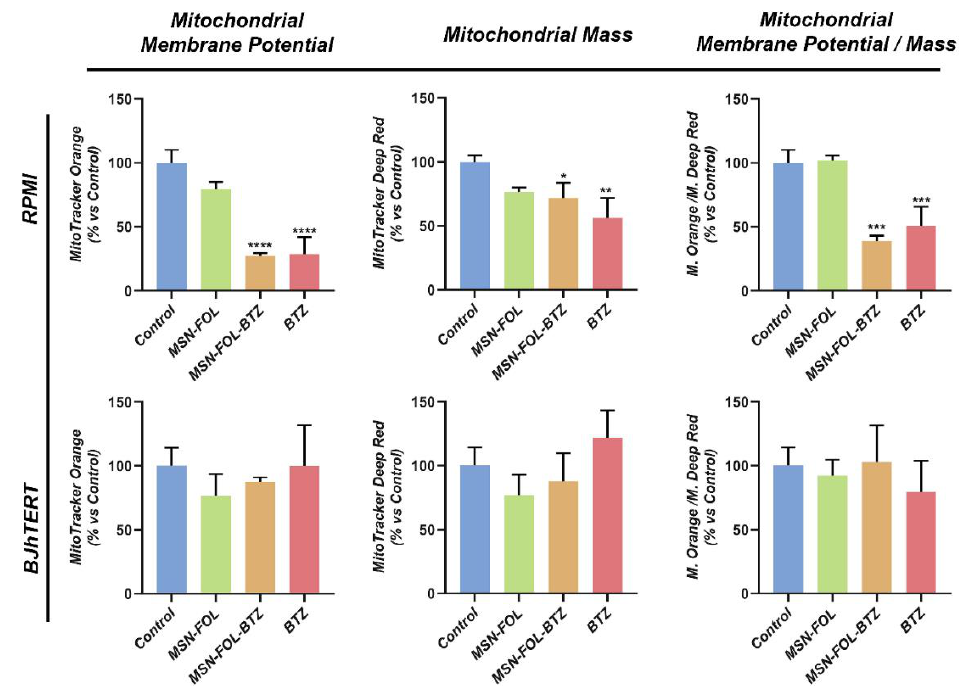
Figure 5. FOL-MSN-BTZ selectively affects mitochondrial function in MM cells. FR+ RPMI-8226 (RPMI) and FR- BJhTERT cells were treated or not (Control) with MSN-FOL, FOL-MSN-BTZ and free BTZ for 1 h and processed, after 24 h, for mitochondrial function analysis. Mitochondrial membrane potential and mitochondrial mass were assessed using MitoTracker Orange CM-H2TMRos and MitoTracker Deep Red probes, respectively, in RPMI and BJhTERT cells. The ratio between mitochondrial membrane potential and mitochondrial mass is also displayed. Values are expressed as mean ± SD of three independent experiments. (*) p < 0.05; (**) p < 0.01; (***) p < 0.001; (****) p < 0.0001.